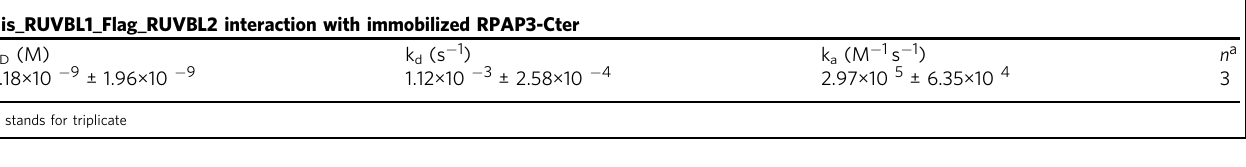
Fig. 2 RPAP3-Cter interacts with RUVBL1/2 hexamers. a SILAC proteomic analysis of RPAP3-Cter. The graph depicts the proteins identi fi ed in anti-GFP immuno-precipitates of HeLa cells expressing GFP-RPAP3-Cter. Each dot is a protein and the color code is indicated below the graph. X -axis: protein abundance (Log10 of signal intensity); y-axis: enrichment over a control IP (Log2 of SILAC ratio). b NMR interaction analysis of RPAP3-Cter with recombinant RUVBL1/2 complex. The graph depicts 1D NMR METHYL-SOFAST-HMQC spectra in the methyl region of 13 C-labeled RPAP3-Cter alone (top lane) or mixed with recombinant RUVBL1/2 complex (bottom lane). Intensity of the NMR signal (arbitrary units, Y -axis) is plotted against the 1 H chemical shift (in ppm, X -axis). c SPR binding assays of RPAP3-Cter with RUVBL1/2. The graph depicts the response upon injecting the RUVBL1/2 complex (t = 0 s), or upon washing (t = 300 s), on immobilized RPAP3-Cter. X -axis: time (s); Y -axis: response (arbitrary units). These data have been obtained with the same batch of RUVBL1/2 complex as in the control experiment (Fig. S2E, F). d Chromatographic analysis of the RUVBL complexes. The graph depicts the chromatograms of puri fi ed RUVBL1 – RUVBL2 (dashed gray, left Y axis) or RUVBL1-RUVBL2-RPAP3-Cter (black line, right Y axis), on a Superose 6 16/70 XK. X-axis: elution volume; Y-axis: absorbance. e Electrophoresis of the puri fi ed RUVBL1 – RUVBL2 – RPAP3 – Cter complex. The gel shows the peak fraction of the complex eluted from the column (black line in d), with a purity estimated to ~95 %. Lane 1: Precision Plus Protein Unstained Standards (Biorad); Lane 2: denatured RUVBL1 – RUVBL2 – RPAP3 – Cter complex. Black and white arrows: RUVBL1 and RUVBL2 (52 and 53 kDa, respectively); gray arrow: RPAP3-Cter (15 kDa). f Native mass spectrometry analysis of recombinant RUVBL complexes. The upper mass spectrum presents the puri fi ed RUVBL1/2 complex. The bottom mass spectrum presents the same complex after addition of RPAP3-Cter. Y-axis: signal intensity; X-axis: m/z. Insets: zoom over the 8000 – 9000 m/z region. Schematics depict the complex observed. Blue: RUVBL proteins; red: RPAP3-Cter